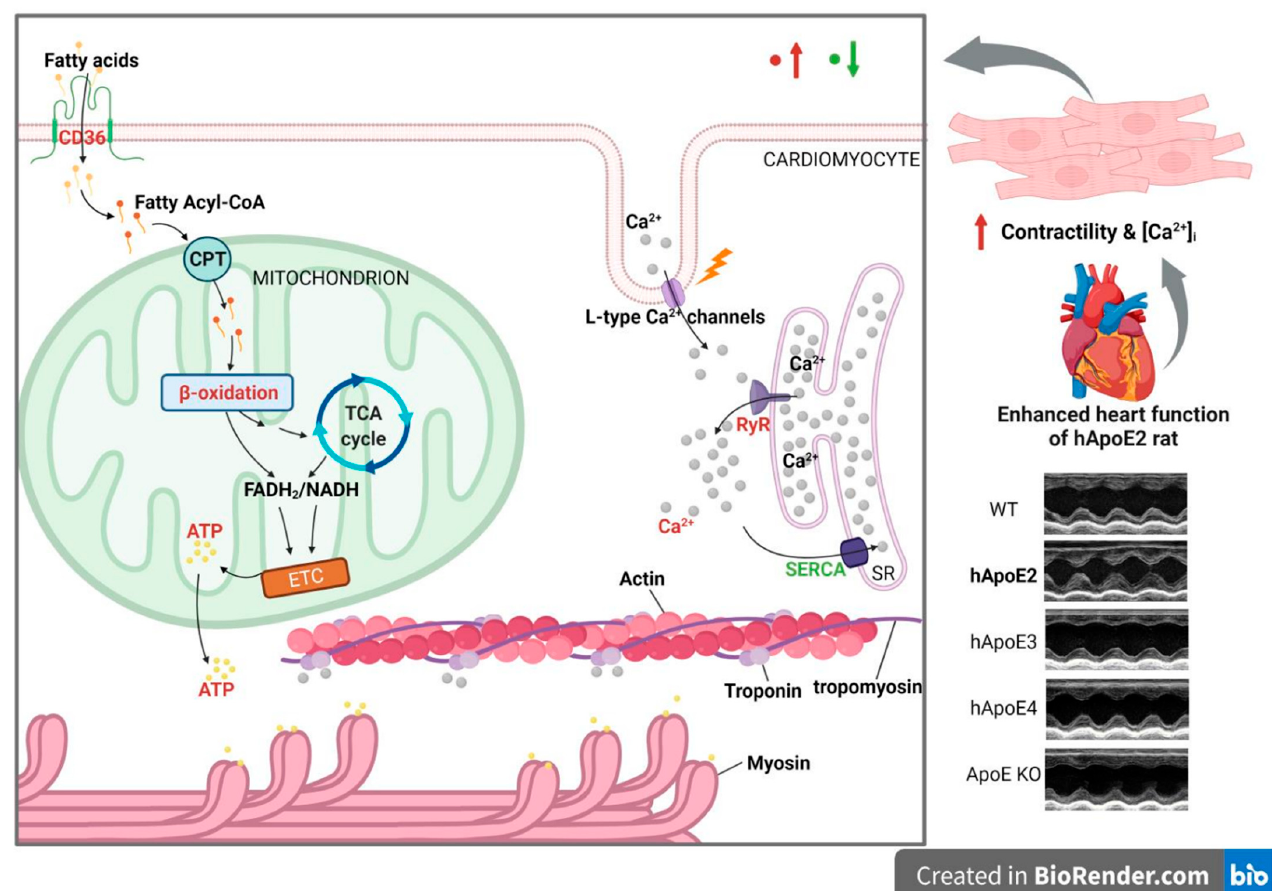
Figure 6. The possible mechanism of how ApoE2 is responsible for enhanced heart function. hApoE2 rat shows enhanced left ventricular function in comparison to hApoE3, E4, WT, and ApoE KO rats via echocardiography. Isolated adult hApoE2 cardiomyocytes showed stronger cellular contractility and higher intracellular Ca 2+ concentration after electric stimulation. Two mechanisms might contribute to the potent contractility of hApoE2 cardiomyocytes: sufficient energy supply and potent Ca 2+ -induced Ca 2+ release from the sarcoplasmic reticulum (SR). The former was a result of robust mitochondrial fatty acid β -oxidation and enhanced fatty acid uptake by fatty acid transporting protein CD36. The latter was a consequence of the considerable Ca 2+ release from the sarcoplasmic reticulum through increased ryanodine receptors (RyR) accompanied by the slightly decreased expression of Ca 2+ reuptake protein sarcoplasmic reticulum Ca 2+ ATPase (SERCA). The red-colored objects denote those augmented signals in hApoE2 cardiomyocytes. The green-colored objects denote the suppressed signals. (Created with BioRender.com).